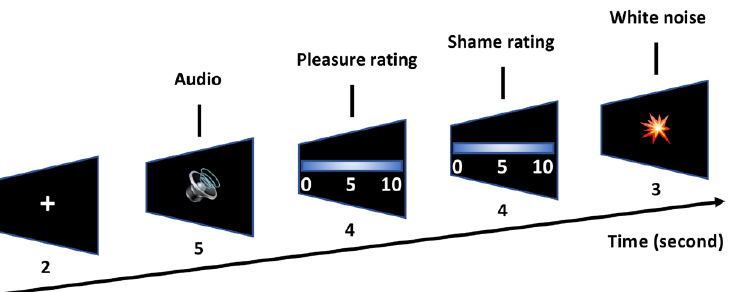
Figure 1. Experimental protocol. A single block is presented here for illustration purposes. Each block consisted of 6 trials, with 2 in each stimulus category. A total of three blocks were performed.